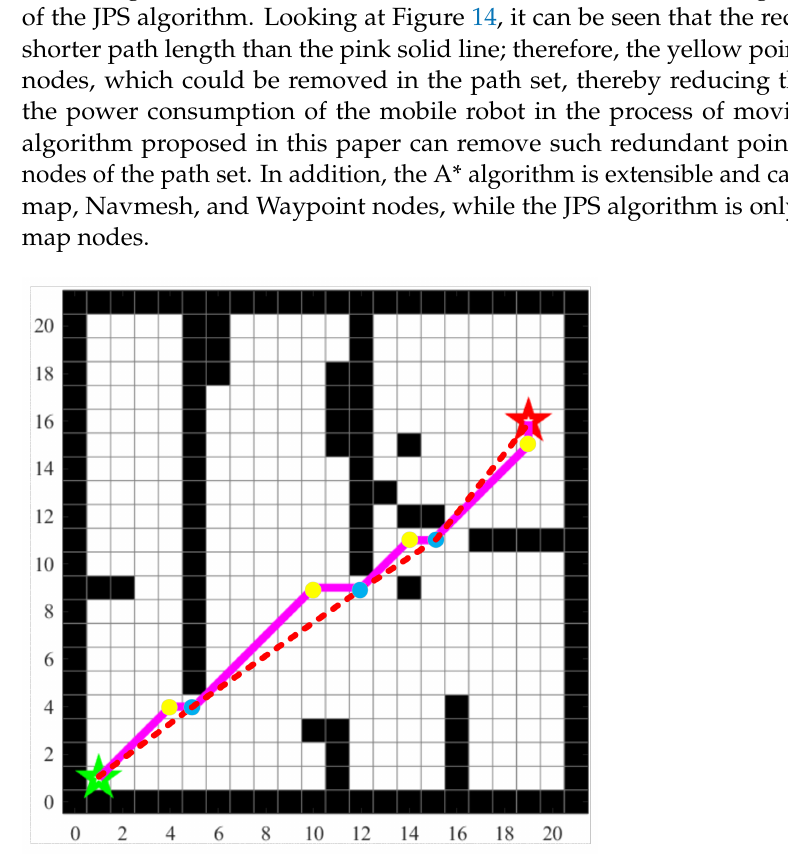
Figure 14. JPS algorithm path planning result. Black represents obstacles. The green five-pointed star represents the starting point, the red five-pointed star represents the target point, and the pink solid line represents the path planning result of the JPS algorithm. The red dashed line represents the connection between nodes. Yellow dots represent path planning